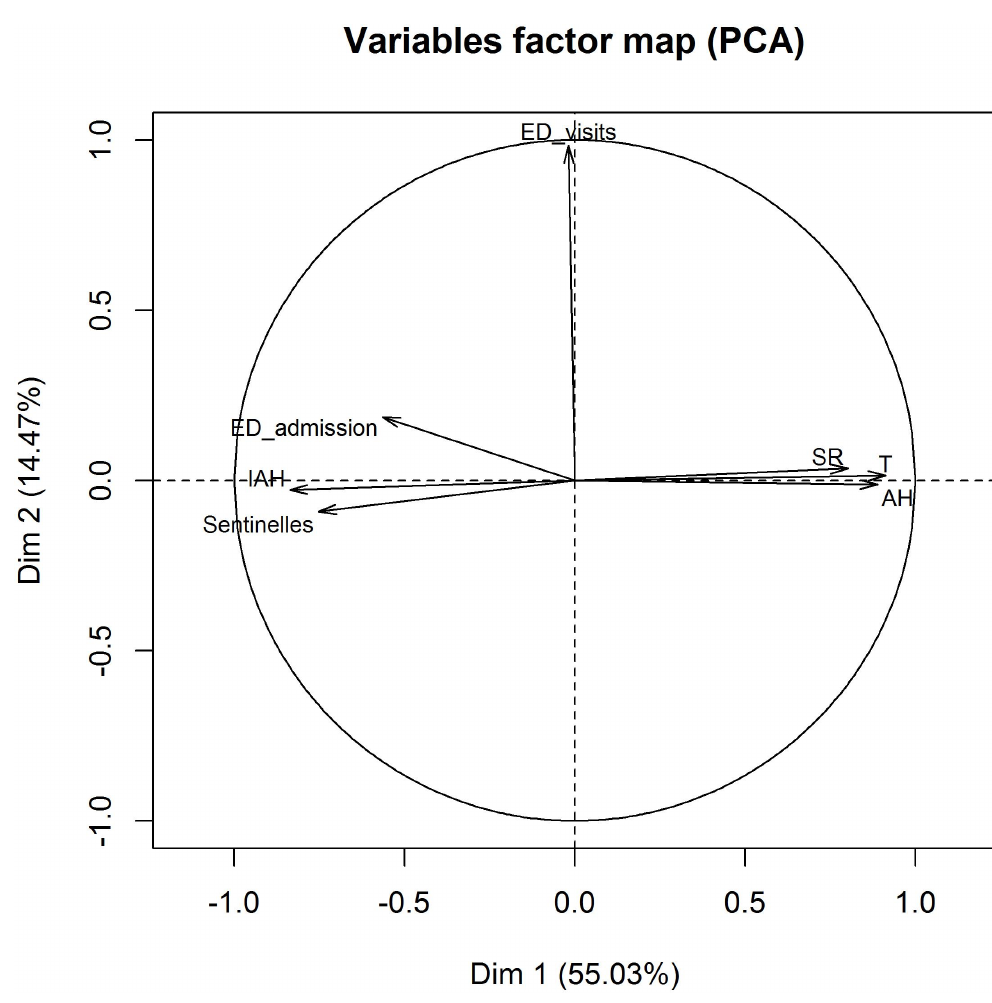
Fig 4. Projection of variables on the first two PCA factorials. IAH = Influenza-Associated Hospitalizations; ED = Emergency Department; AH = Absolute Humidity; SR = Solar Radiation; T =